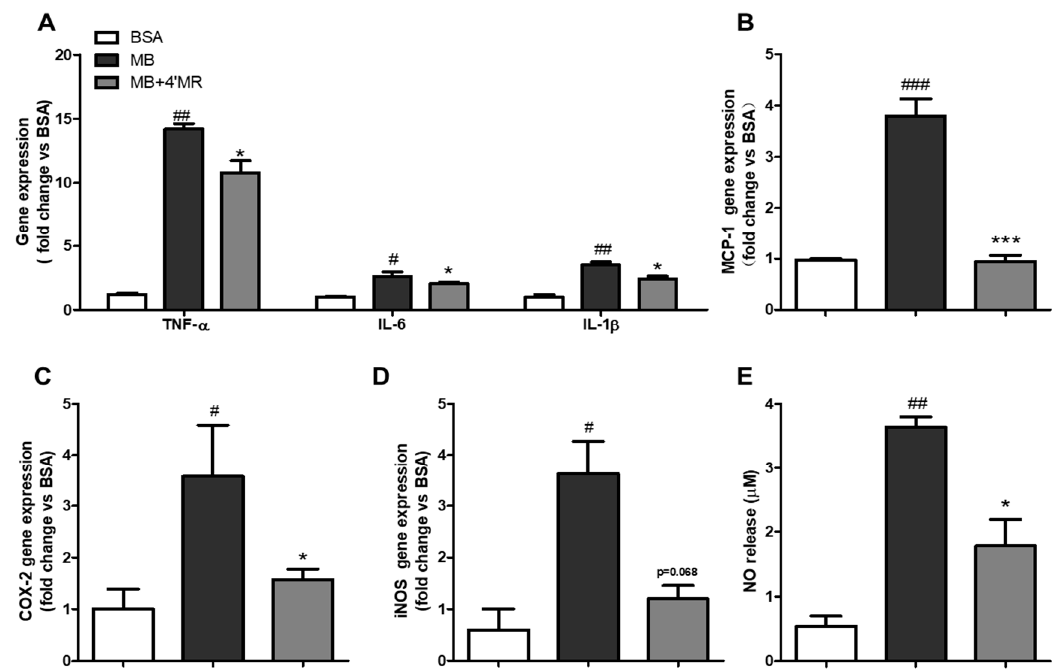
Figure 1. 4 ′ -Methoxyresveratrol modulated pro-inflammatory gene expression induced by MB in RAW264.7 macrophages. ( A – D ) TNF- α , IL-6, IL-1 β , MCP-1, COX2, and iNOS mRNA levels were determined by qPCR. Gene expression was normalized to 18S. ( E ) NO level was analyzed by Griess method in culture supernatant. Cells were treated with 200 µg/mL of BSA or MB with or without 10 µM 4 ′ MR for 24 h. All data are averages of triplicates from three separate experiments. # p < 0.05, ## p < 0.01, ### p < 0.001 vs. BSA; * p < 0.05, *** p < 0.001 vs. MB. 4 ′ MR, 4 ′ -Methoxyresveratrol.